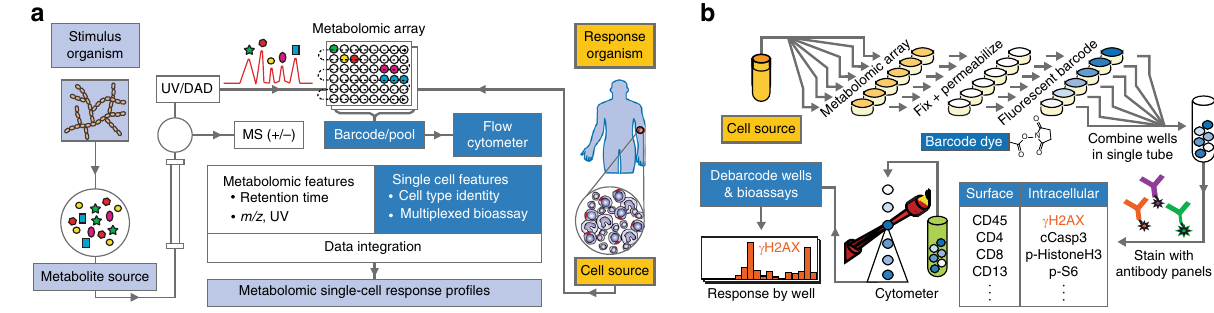
Fig. 1 Metabolome functional analysis by multiplexed activity metabolomics (MAM). a High-data-content metabolomic arrays are generated in replicate from a “ stimulus ” organism via split- fl ow polarity switching chromatography mass spectrometry. A suspension of disaggregated tissue cells from a “ response ” organism (human) is added to the metabolomic array. b Flow cytometric cell barcoding and multiplexed immunoassays are used to identify multiple cell type/subtype-speci fi c biological responses to metabolites in the array. Correlation analysis of the resulting bioactivity and UV/ESI/MS( ±